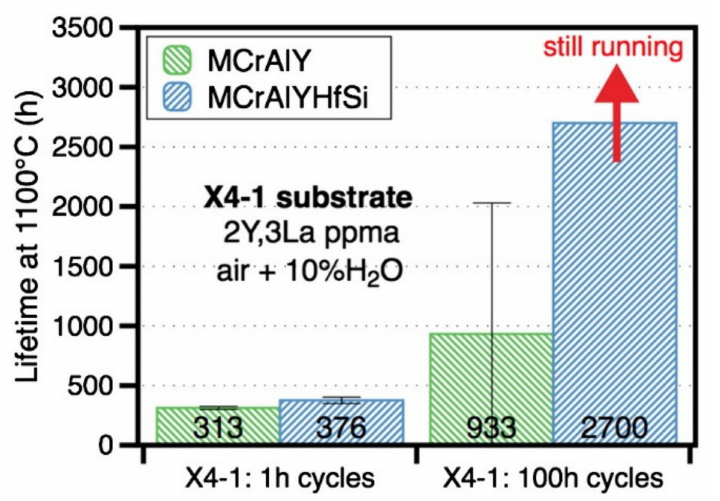
Figure 4. Comparison of the effects of cycle length (1 h vs. 100 h) and HVOF bond coat composition (NiCoCrAlY vs. NiCoCrAlYHfSi) on average time to APS TBC failure on X4-1 during 1 h furnace cycles at 1100 ◦ C in air + 10 vol.% H 2 O